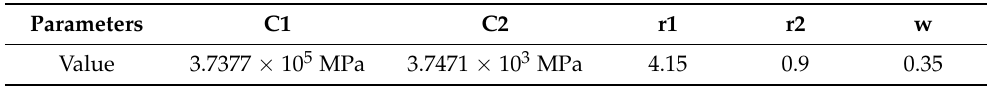
Table 2. TNT explosive parameters.